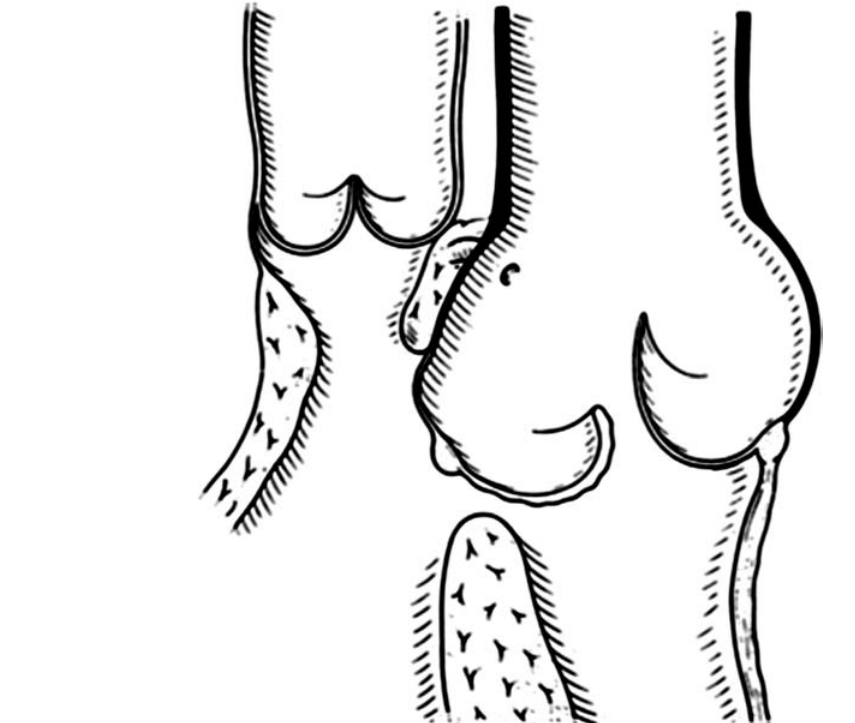
Figure 4. Cartoon showing discontinuity between the aortic media and the ventricular septal crest. (With permission J Thorac Cardiovasc Surg 1997;113:253–261.)